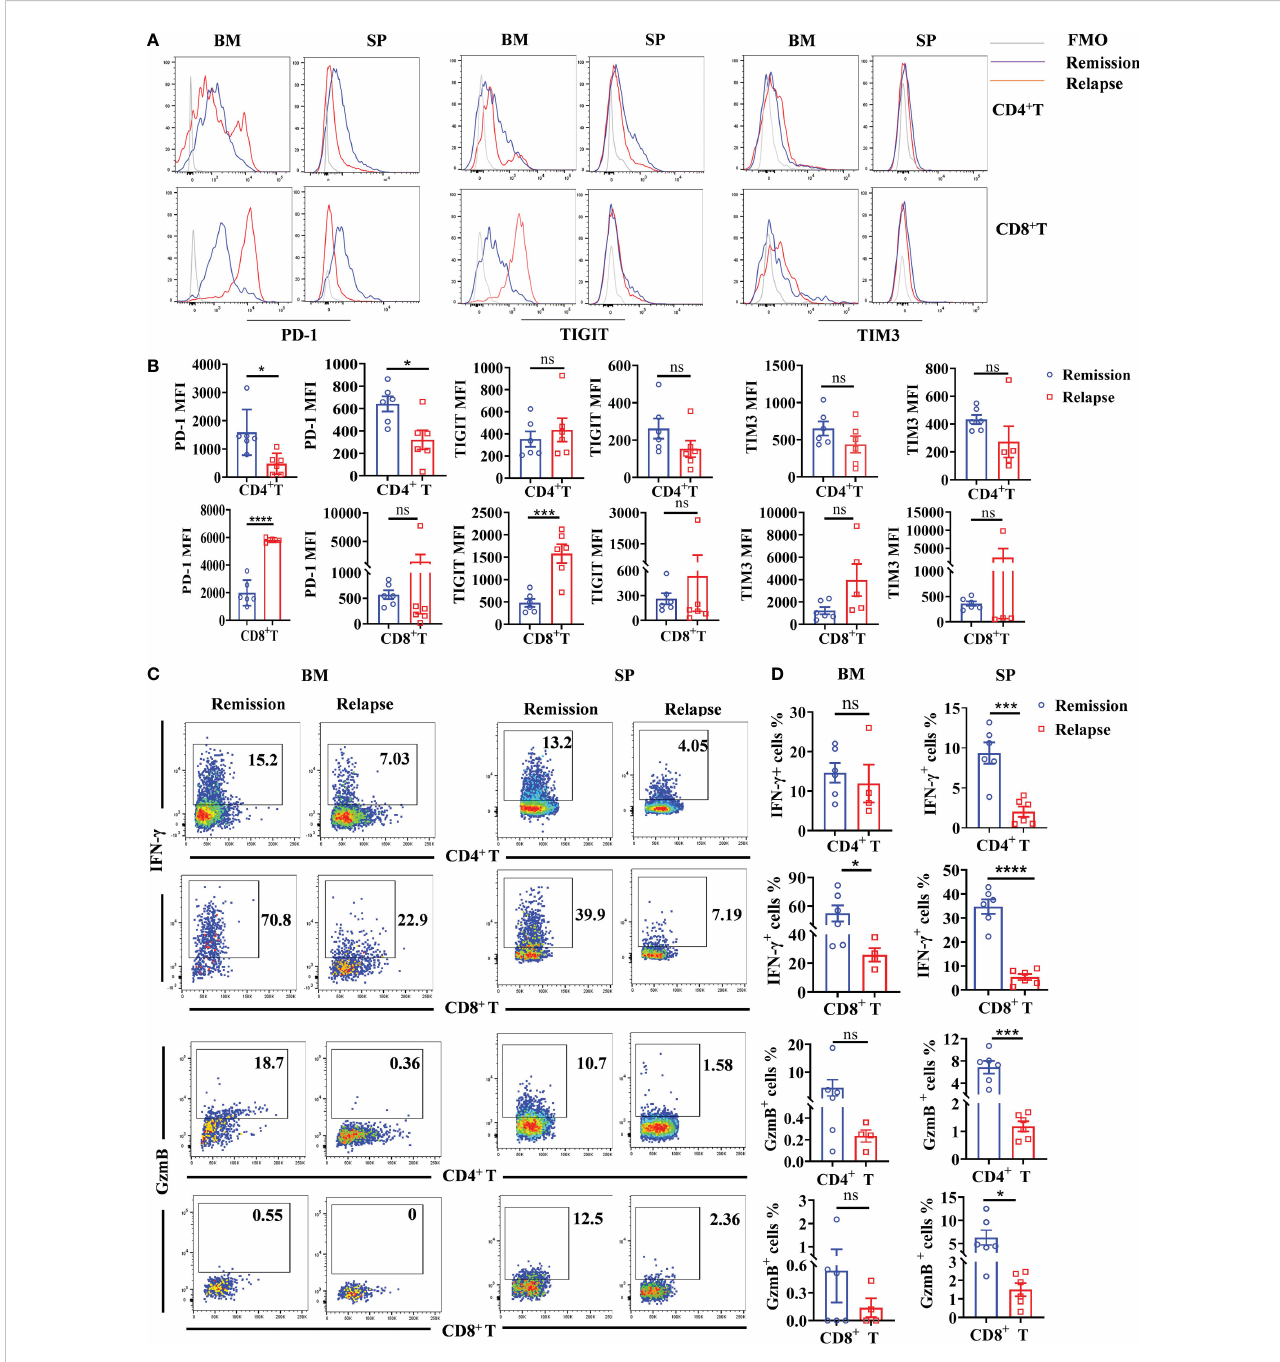
FIGURE 7 Increased exhausted characteristics and decreased cytotoxicity of intrinsic CD8 + T cells in the TME of relapsed mice. BM and spleen were harvested from lymphoma mice during the remissive and relapsed stages after anti-CD19 CAR T-cell treatment, respectively. (A) The representative fl uorescence intensities of PD-1, TIGIT, and TIM3 on intrinsic T cells were shown. (B) The statistical differences between remissive and relapsed mice were compared. (C, D) The production of IFN- g and GranzymeB by intrinsic T-cell subsets. Each symbol represents one individual mouse. Data were mean ± SD and compared using unpaired Student ’ s t-test. * P < 0.05, *** P < 0.001, **** P < 0.0001, ns P >